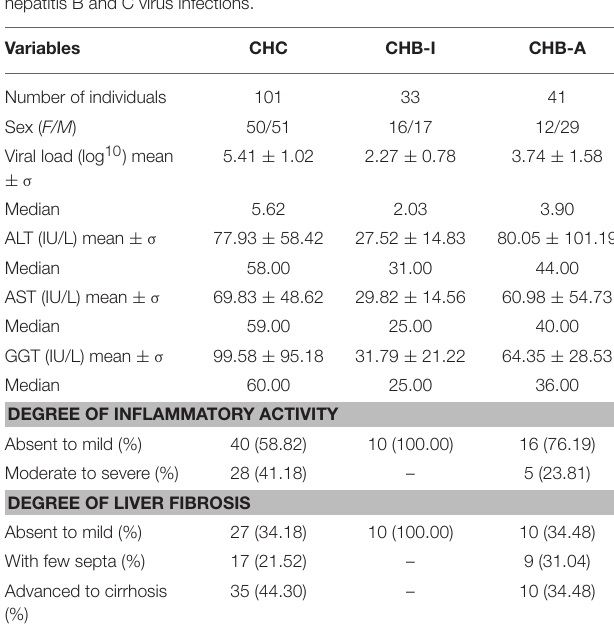
FIGURE 1 | Amplification plots of the genotypes for the studied polymorphisms. The amplification curves are based on the fluorescence intensity variation ( 1 Rn) according to the number of PCR cycles for the wild-type homozygous (A,D,G) , heterozygous (B,E,H) and mutant homozygous (C,F,I) genotypes of the FOXP3 polymorphisms. TABLE 1 | Laboratory and histopathological data for patients with chronic hepatitis B and C virus